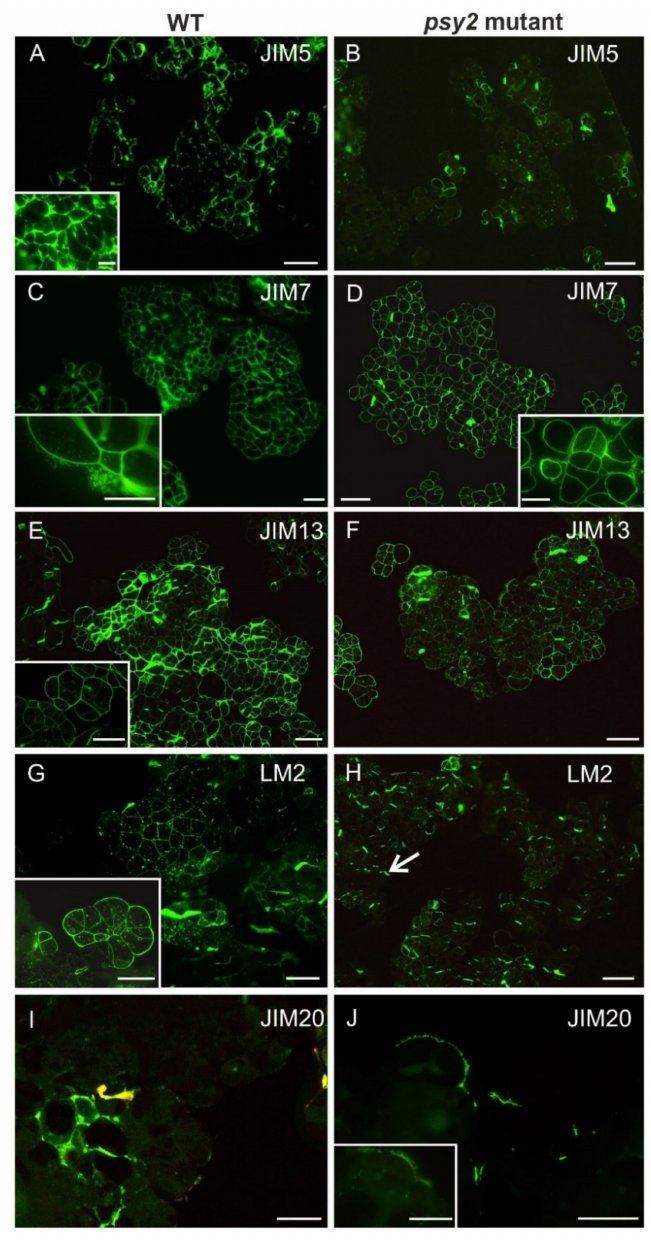
Figure 5. Distribution of pectic, AGPs, and extensin epitopes in callus cells of the WT (not transformed control) and psy2 mutant. ( A ) The pectic epitope recognised by JIM5 antibody abundantly present in the cell walls (inset–higher magnification). ( B ) The presence of JIM5 epitope in the psy2 mutant cells restricted only to a few cells. ( C ) JIM7 epitope present in all cells of WT (inset—higher magnification showing the presence of the epitope inside and outside the cells). ( D ) The distribution of JIM7 epitope in the psy2 mutant cells (inset—higher magnification showing the presence of the epitope inside and outside the cells). ( E ) The presence of AGP epitope recognised by JIM13 antibody in WT cells. The epitope detected in the walls of all cells (inset—higher magnification showing the presence of the epitope also in the cytoplasmic compartments). ( F ) In psy2 mutant cells the JIM13 epitope detected in much less amount in the cell walls in comparison to WT callus. ( G ) The AGP epitope recognised by LM2 antibody present in the walls of all cells and in the cytoplasmic compartments of WT callus (inset). ( H ) In psy2 mutant cells this epitope detected mainly in new walls (arrow). ( I ) The extensin epitope recognised by JIM20 antibody was present only in the walls of few cells in WT callus. ( J ) In psy2 mutant cells this epitope detected also in some cells, within the walls but also outside the walls (inset). Scale bars: ( A – H ) 200 µ m; (I, J) 100 µ m; insets 100 µ